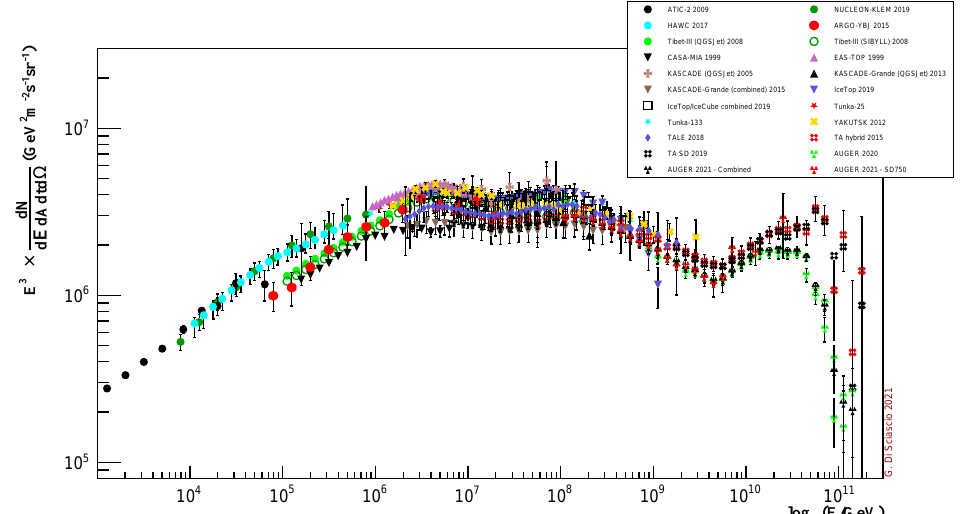
Figure 1. All–particle energy spectrum of primary cosmic rays, the flux is multiplied by E 3 . Results from direct and indirect experiments updated to the year 2021 are